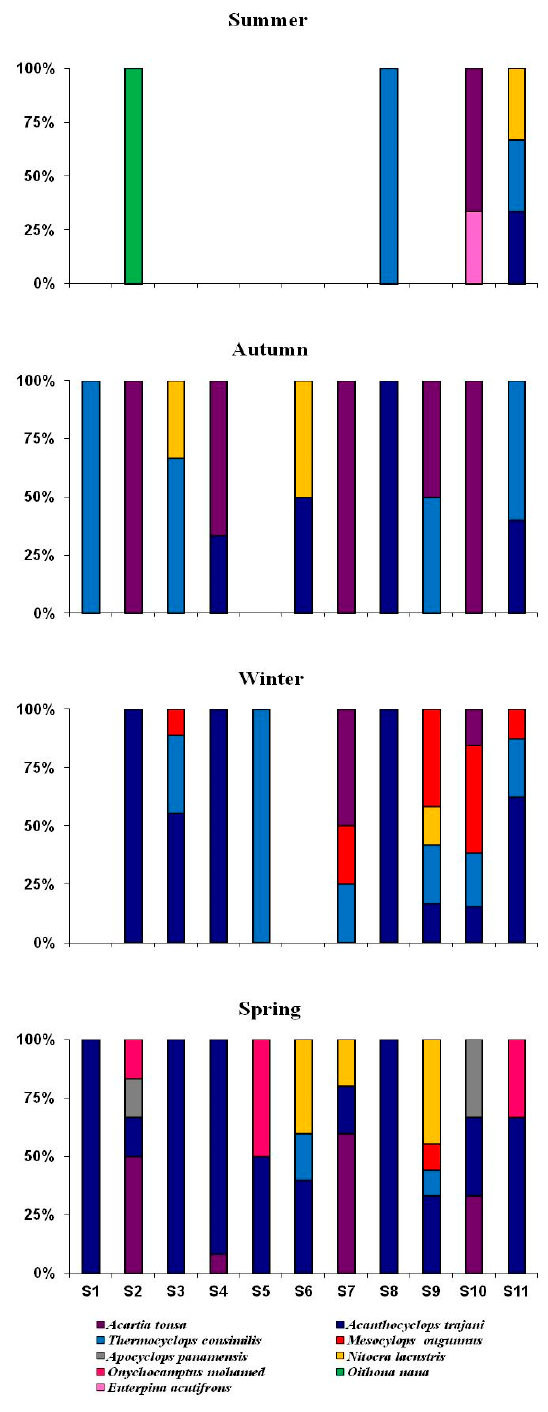
Figure 6. Spatiotemporal variations of adult copepod percentages in Lake Manzalah.